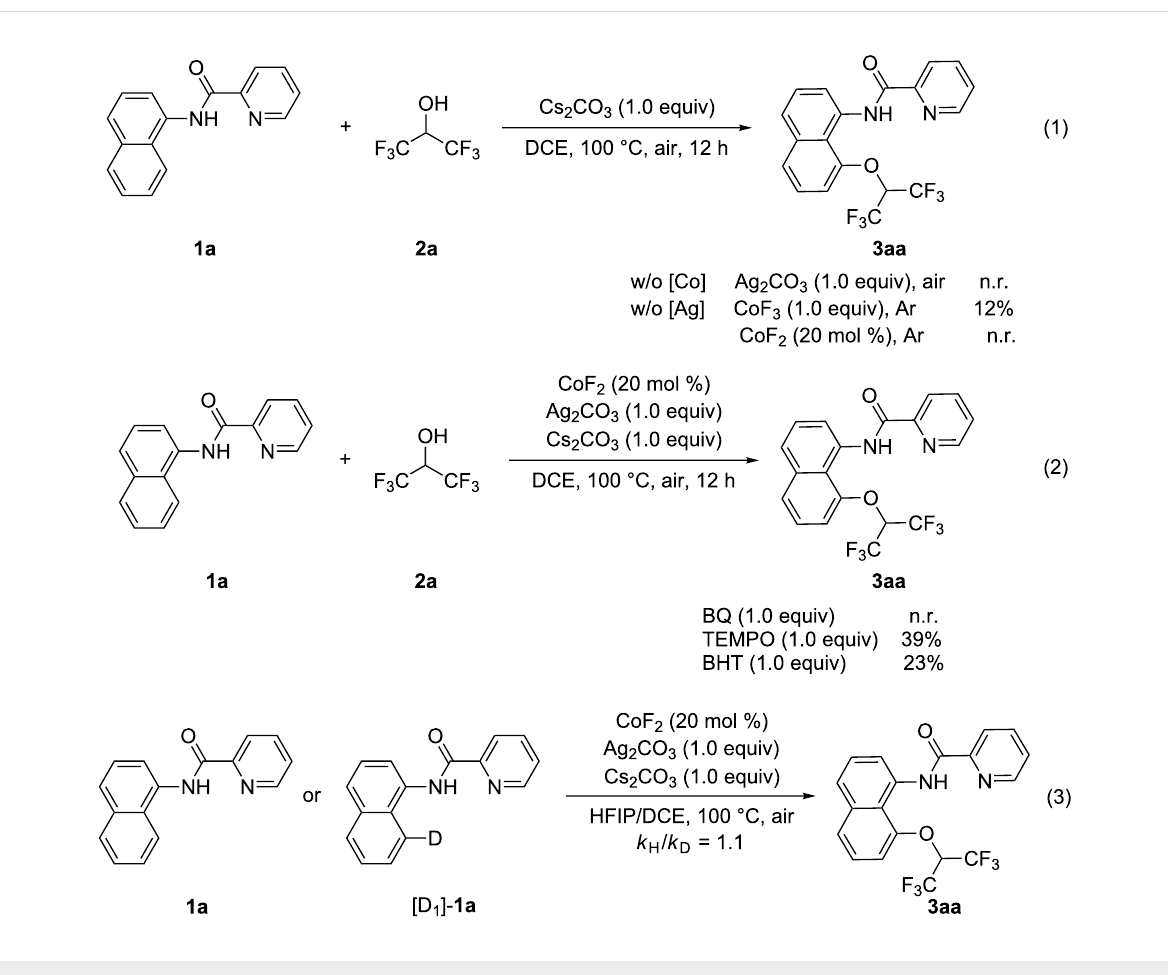
Scheme 3: Control experiments and mechanistic